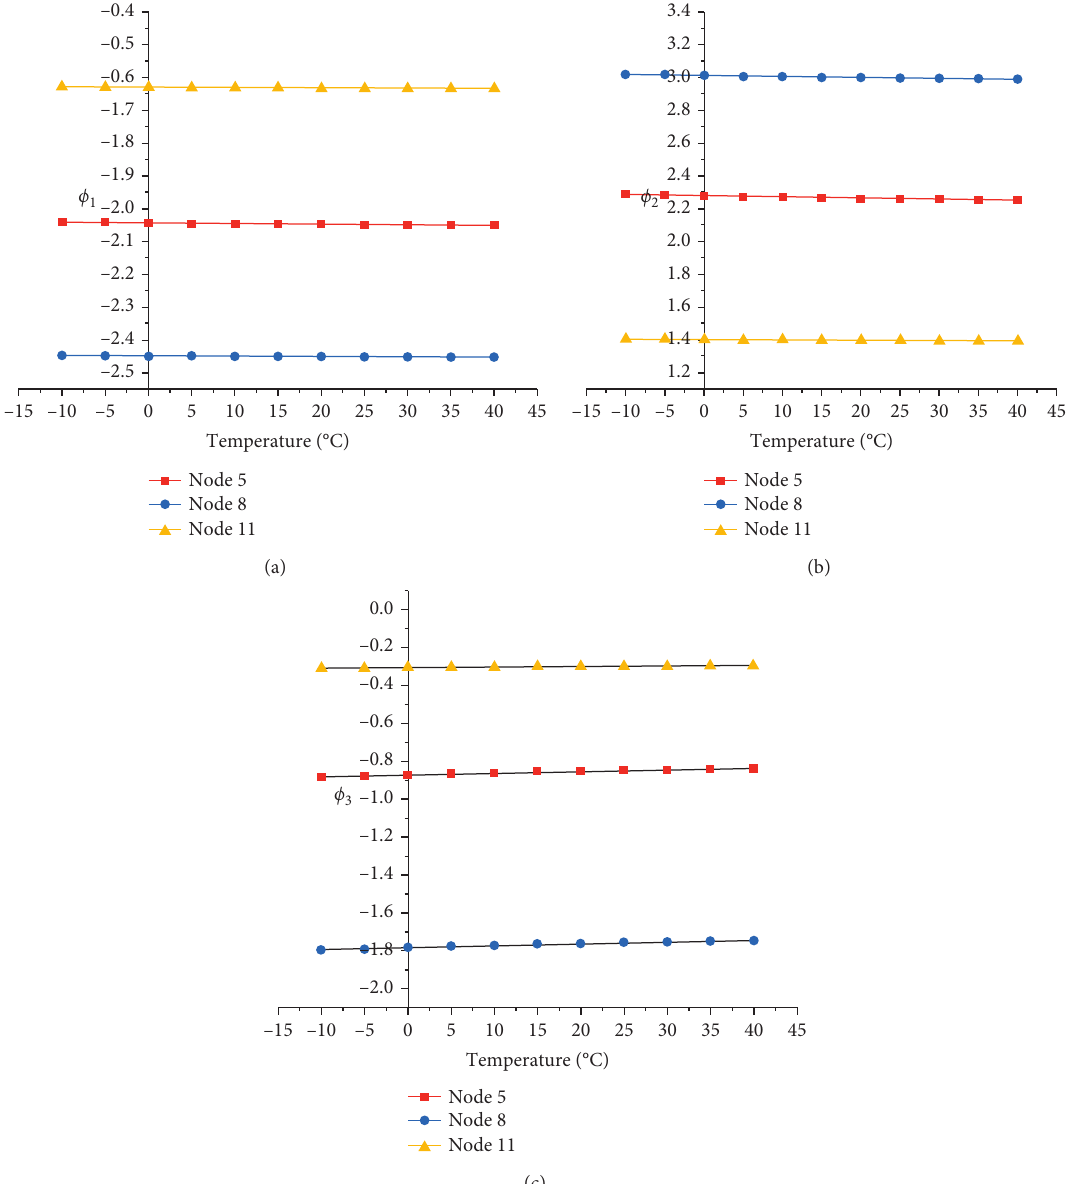
Figure 8: The relationship between the first three-order AR coefficients and temperature: (a) first-order AR coefficients; (b) second-order AR coefficients; (c) third-order AR